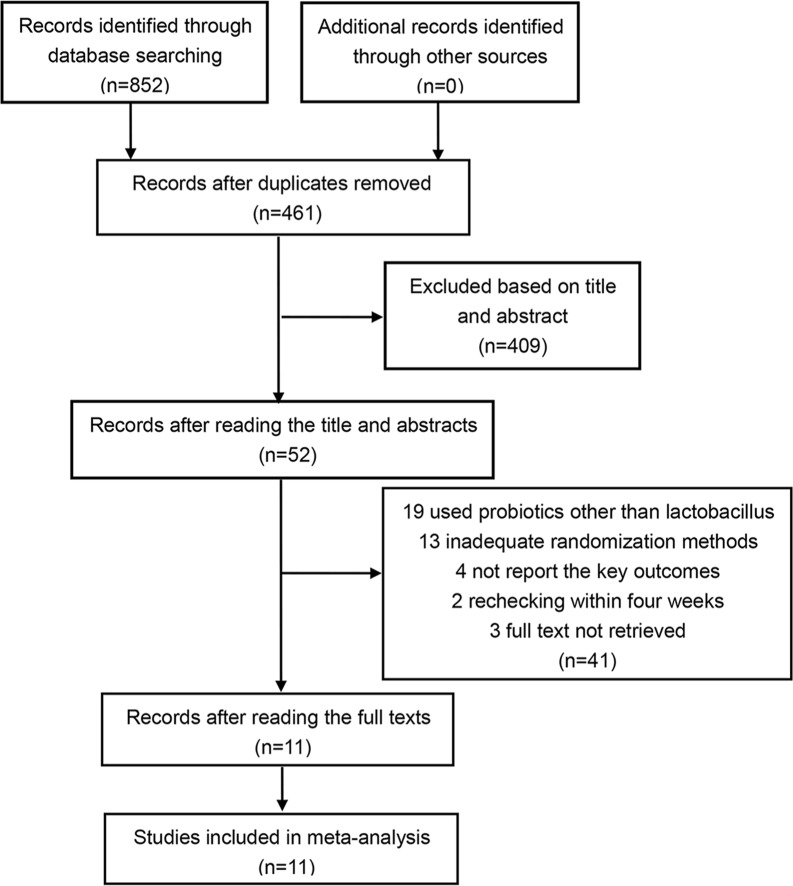
Flowchart of the study selection.